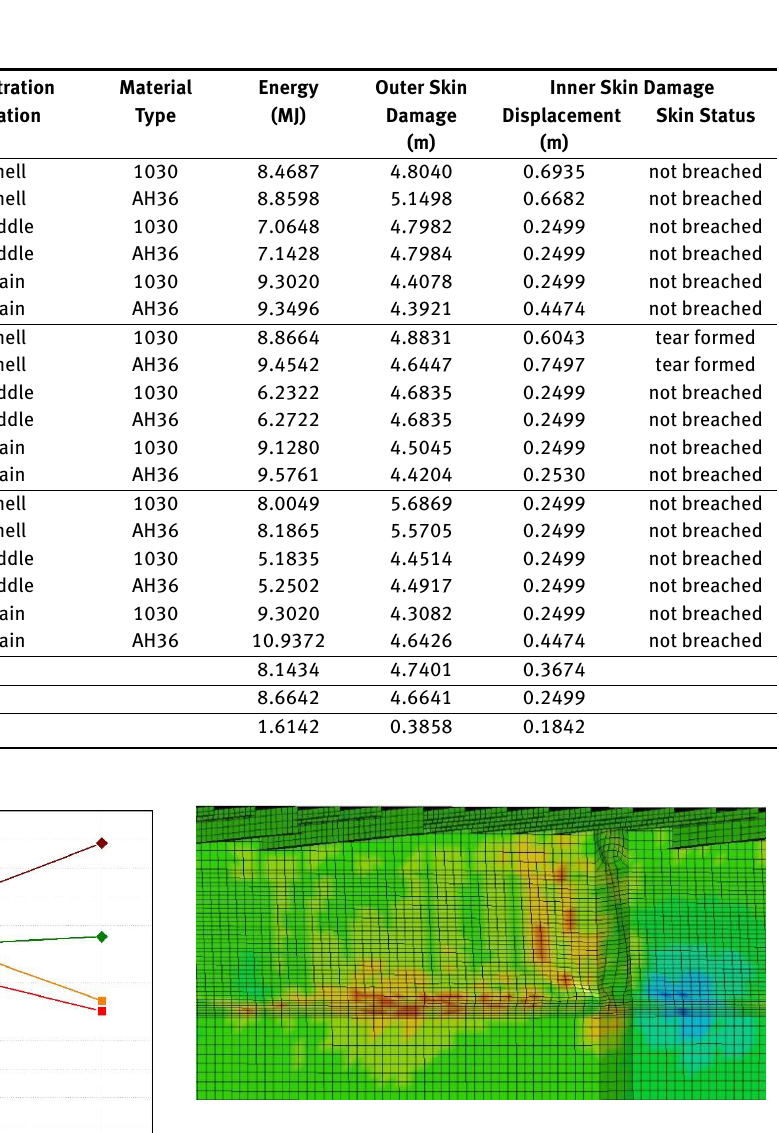
Figure 11: Pressure contour after collision at Location 1.